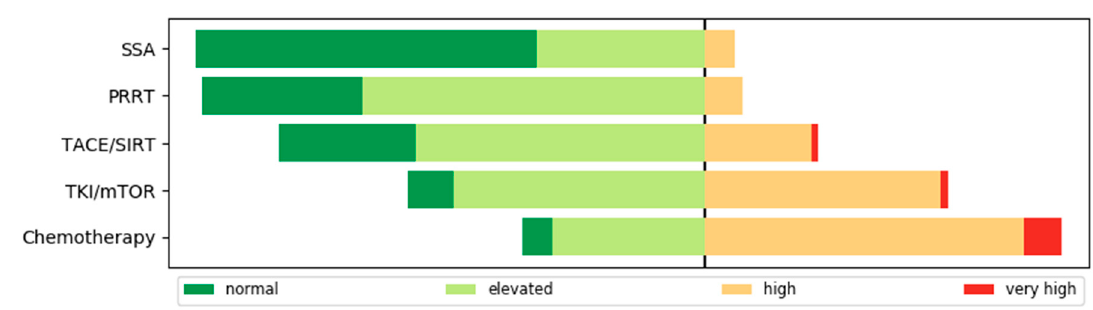
Figure 4. Risk of severe courses of COVID-19 infection under five NET therapy regimens according to physician rating. SSA [63%, 31%, 6%, 0%], PRRT [30%, 63%, 7%, 0%], TKI / mTOR: Everolimus and Sunitinib [8%, 46%, 44%, 1%), TACE / SIRT: Transcatheter arterial chemoembolization and selective internal radiation therapy [25%, 54%, 20%, 1%] and chemotherapy [6%, 28%, 59%, 9%]. For reasons of clarity, the bars have been centered between elevated and high risk.